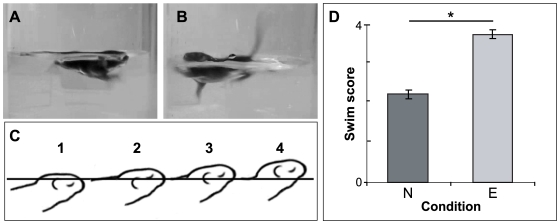
Pre-weaning enrichment improves swimming performance at P10.(A, B) Representative examples of swimming behaviour of non-enriched (A) and enriched (B) mice at P10. In non-enriched mice (A), only the crown of the head and dorsal tip of the nose are above the water level (score of 2). In enriched (B) mice, the bulk of the head, including the entire ear and nose are above the water level (score of 4). The back and tail are also notably more elevated. (C) Drawings illustrating the relative position of the eyes, nose and ears used in the scoring assessment (based on the scheme of St Omer [47]). (D) Graph plotting swim scores for non-enriched (‘N’, n = 17) versus enriched (‘E’, n = 17) P10 mice. Scores were made by an observer blind to treatment group. Enriched mice scored significantly higher than non-enriched controls (Student's t-test, p<0.001). *: p<0.001.